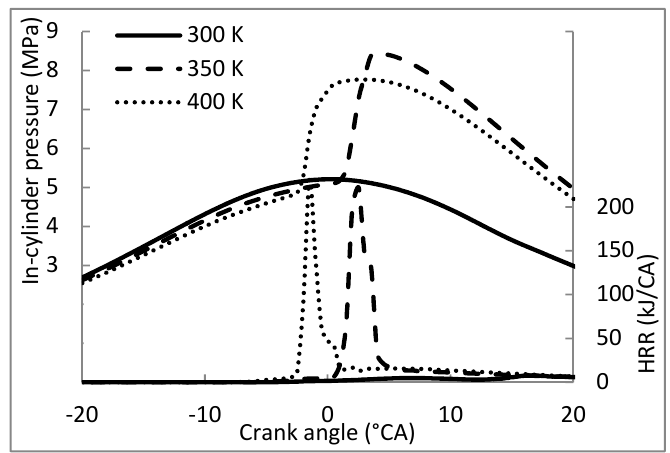
Figure 15. In-cylinder pressure and HRR graph of the D50E40B10 blend against a crank angle at 2400